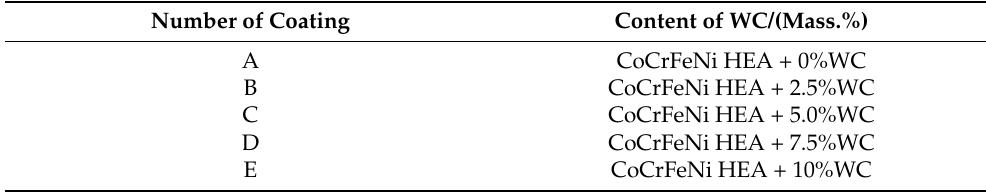
Table 2. Coating numbers with different WC mass